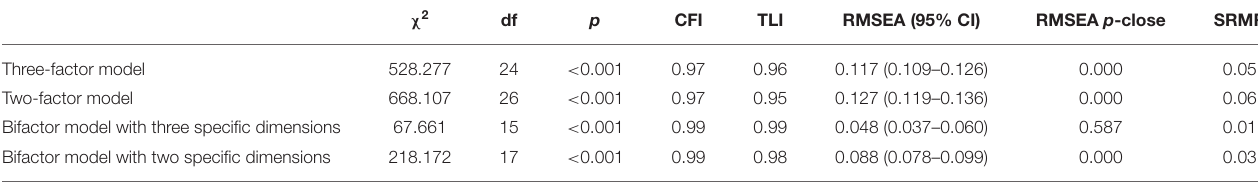
TABLE 2 | Confirmatory factor analysis of four measurement models of the PIUQ-SF-9.